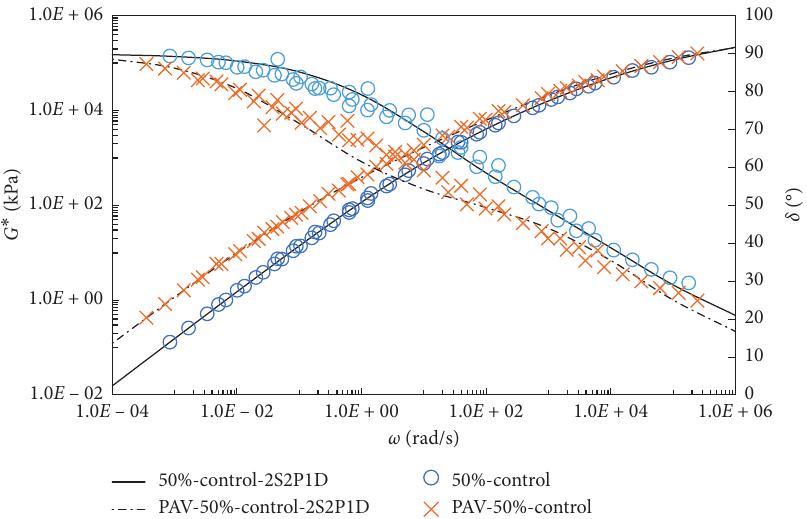
Figure 6: Complex shear modulus and phase angles master curves for control binder containing 50% RAP binder before and after PAV